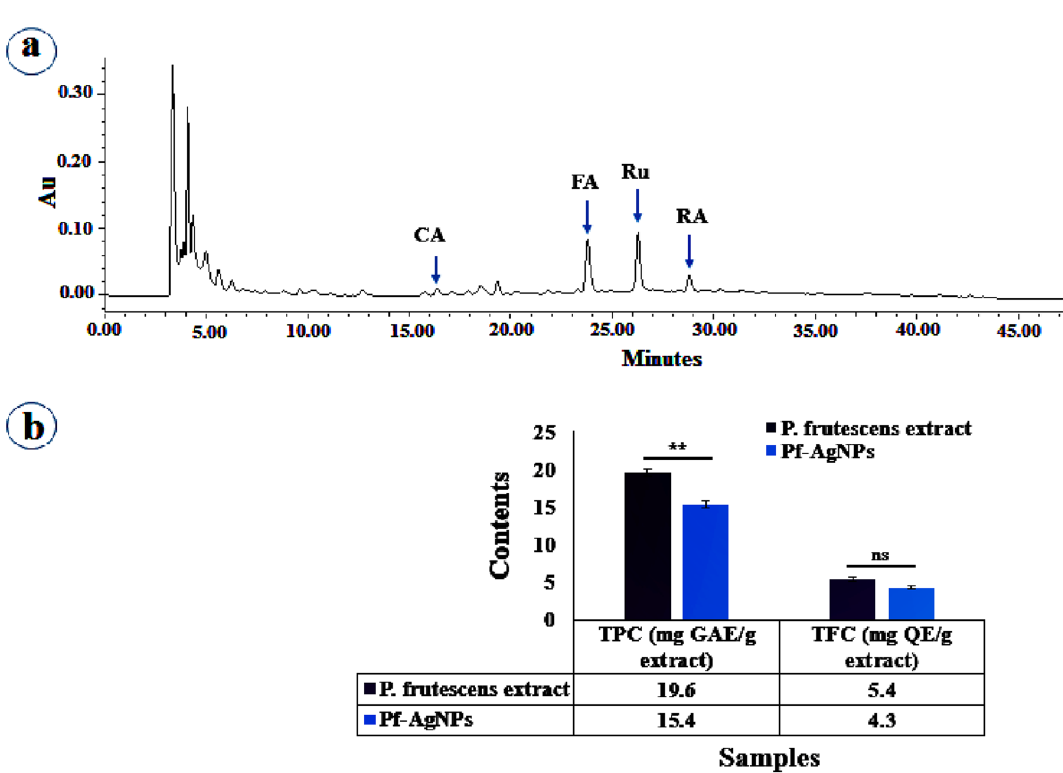
Figure 5. HPLC analysis of aqueous leaf extract of Perilla frutescens ( a ), and total phenol and flavonoid content of the extract of Perilla frutescens and Pf-AgNPs ( b ). CA caffeic acid, FA ferulic acid, Ru rutin, RA rosmarinic acid. Error bar represents standard deviation of mean. ** p ≤ 0.01. Significant difference within a parameter between two lines is denoted by asterisk, and ns, means p >